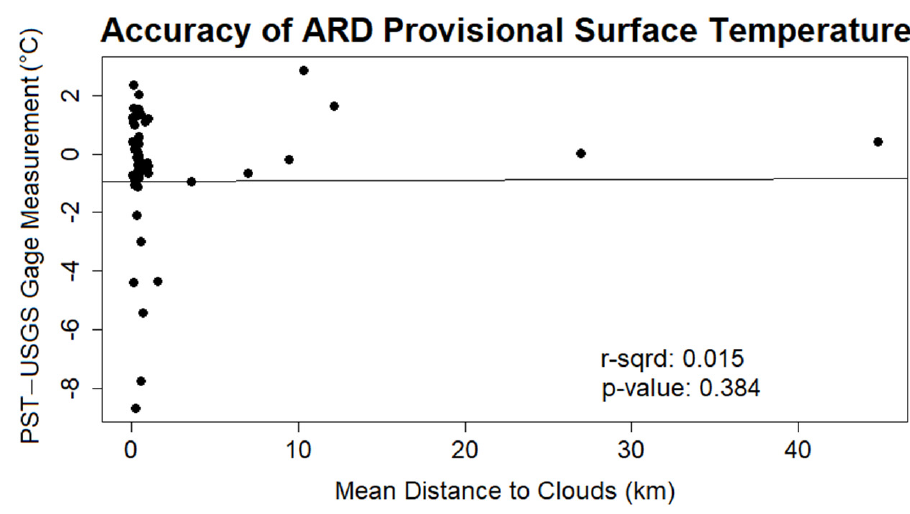
Figure 6. Scatter plot showing how the mean distance to cloud from all quality pixels within the Channel AOI is correlated with the agreement between the estimated and observed water temperature.